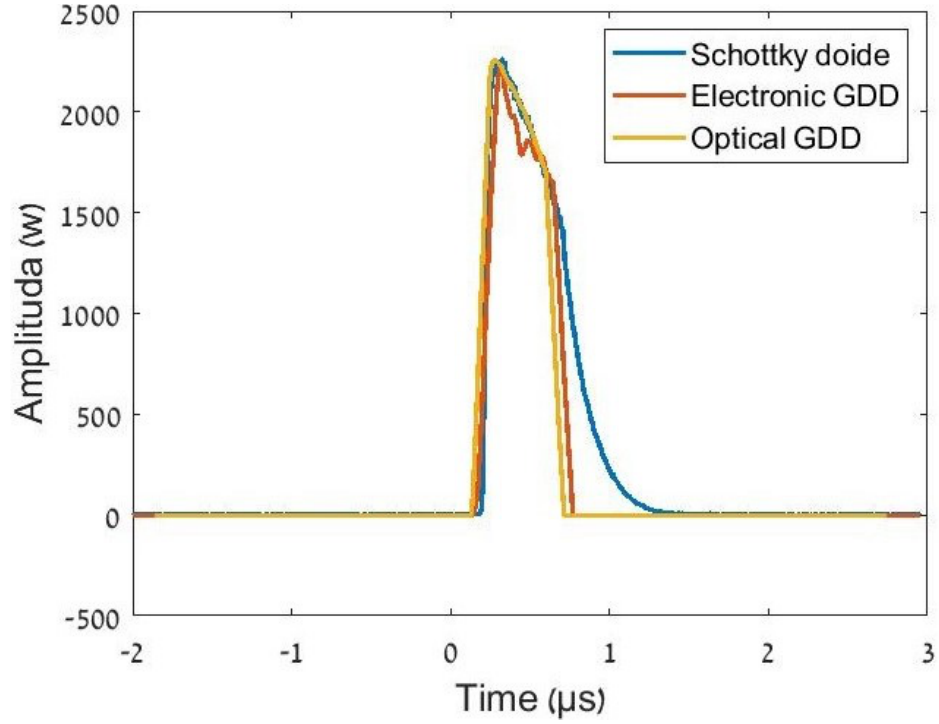
Figure 3. A 0.1 THz pulse detected by three different